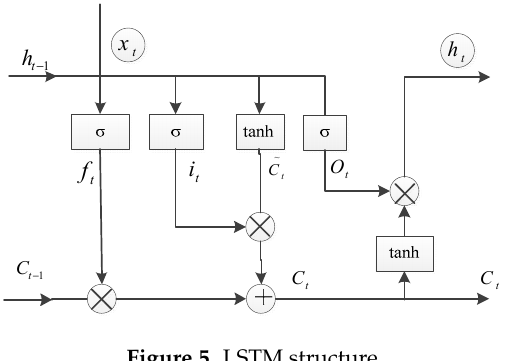
Figure 5. LSTM structure.